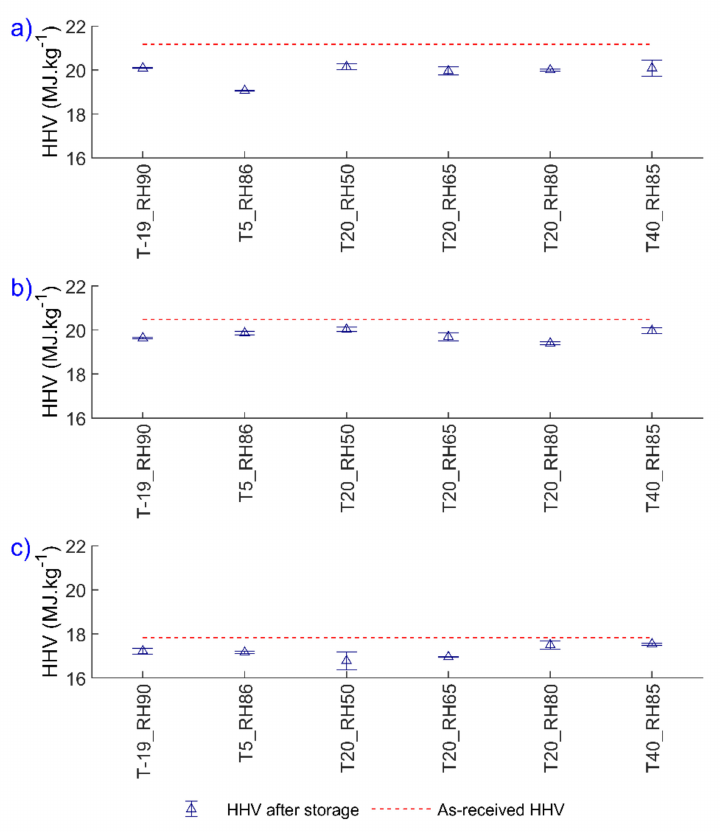
Figure 3. Higher heating values (HHV) of ( a ) brown, ( b ) white, and ( c ) torrefied pellets at di ff erent storage conditions after 30 days of storage.